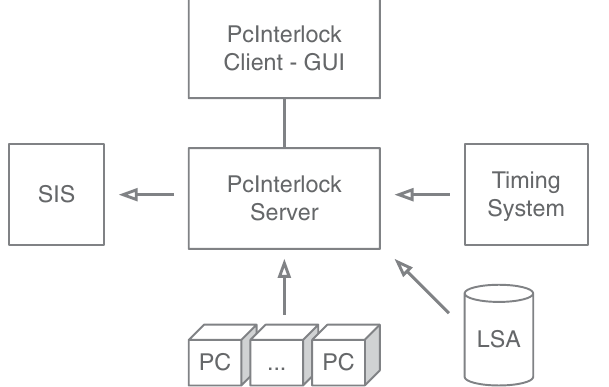
FIG. 4. The client/server architecture of the PcInterlock. It queries the actual current from the PCs of the LHC and their reference settings and tolerances from LSA. Dedicated timing events published by the timing system are used to determine the reference current at any moment for each PC. In case of a mismatch between the actual and the reference current, a signal is sent to the SIS to trigger an